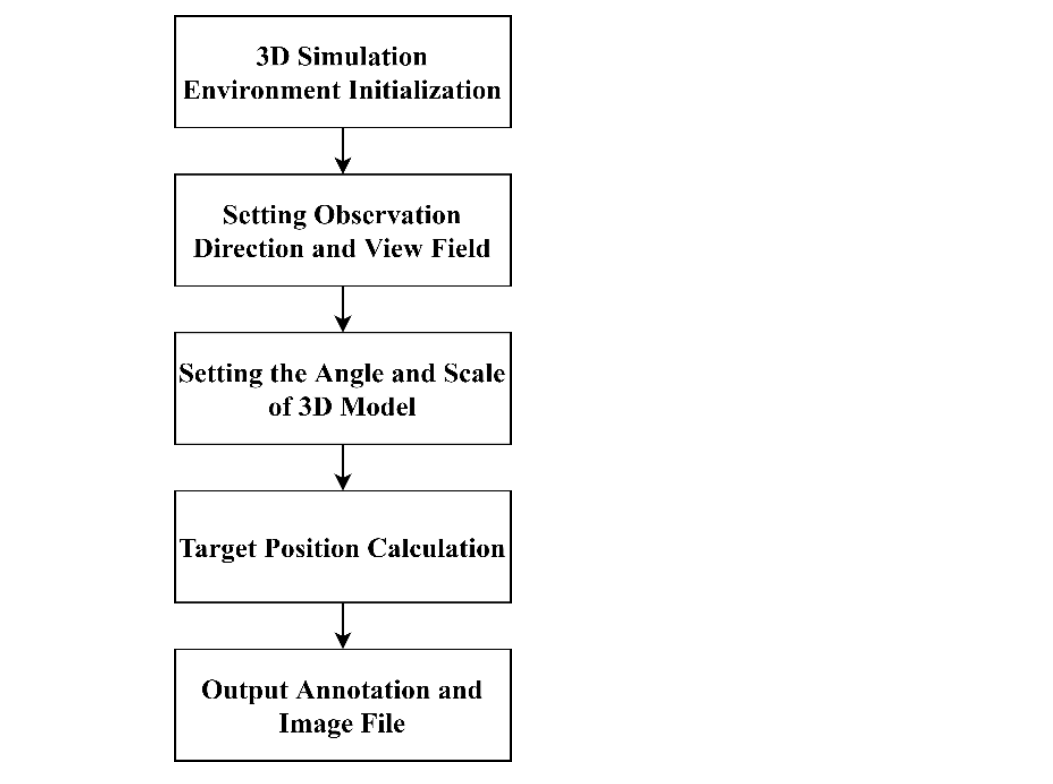
Figure 3. Ship image generation process based on computer simulation.